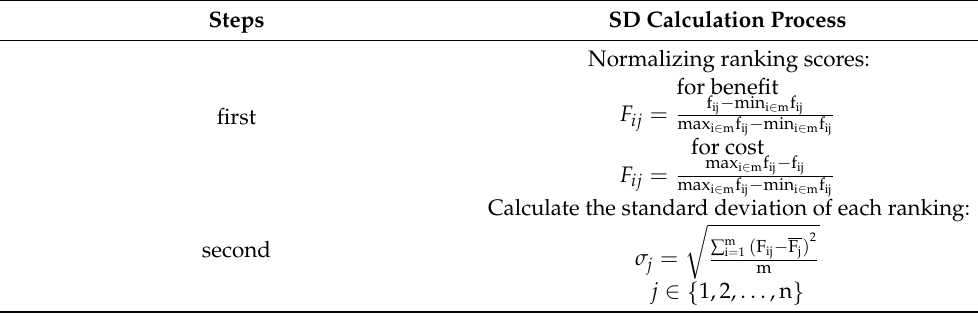
Table 3. Stages of Standard Deviation (SD) Model [38].